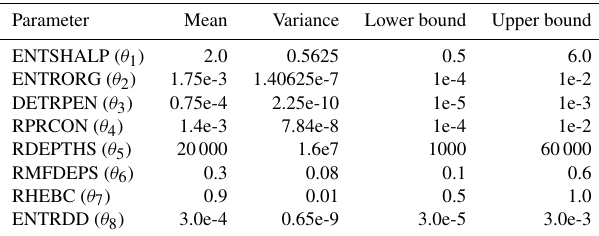
Table A3. Initial parameter value search area of DE. Parameter